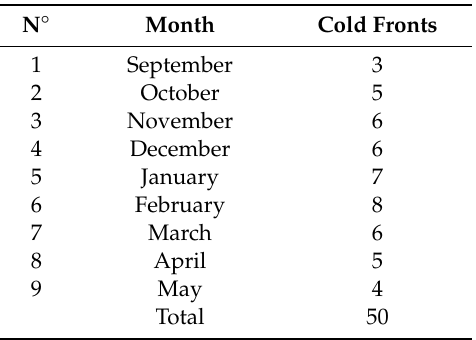
Table 5. Monthly average of cold front occurrence in Mexico between 1981 and 2019. Source: National Meteorological Service of Mexico